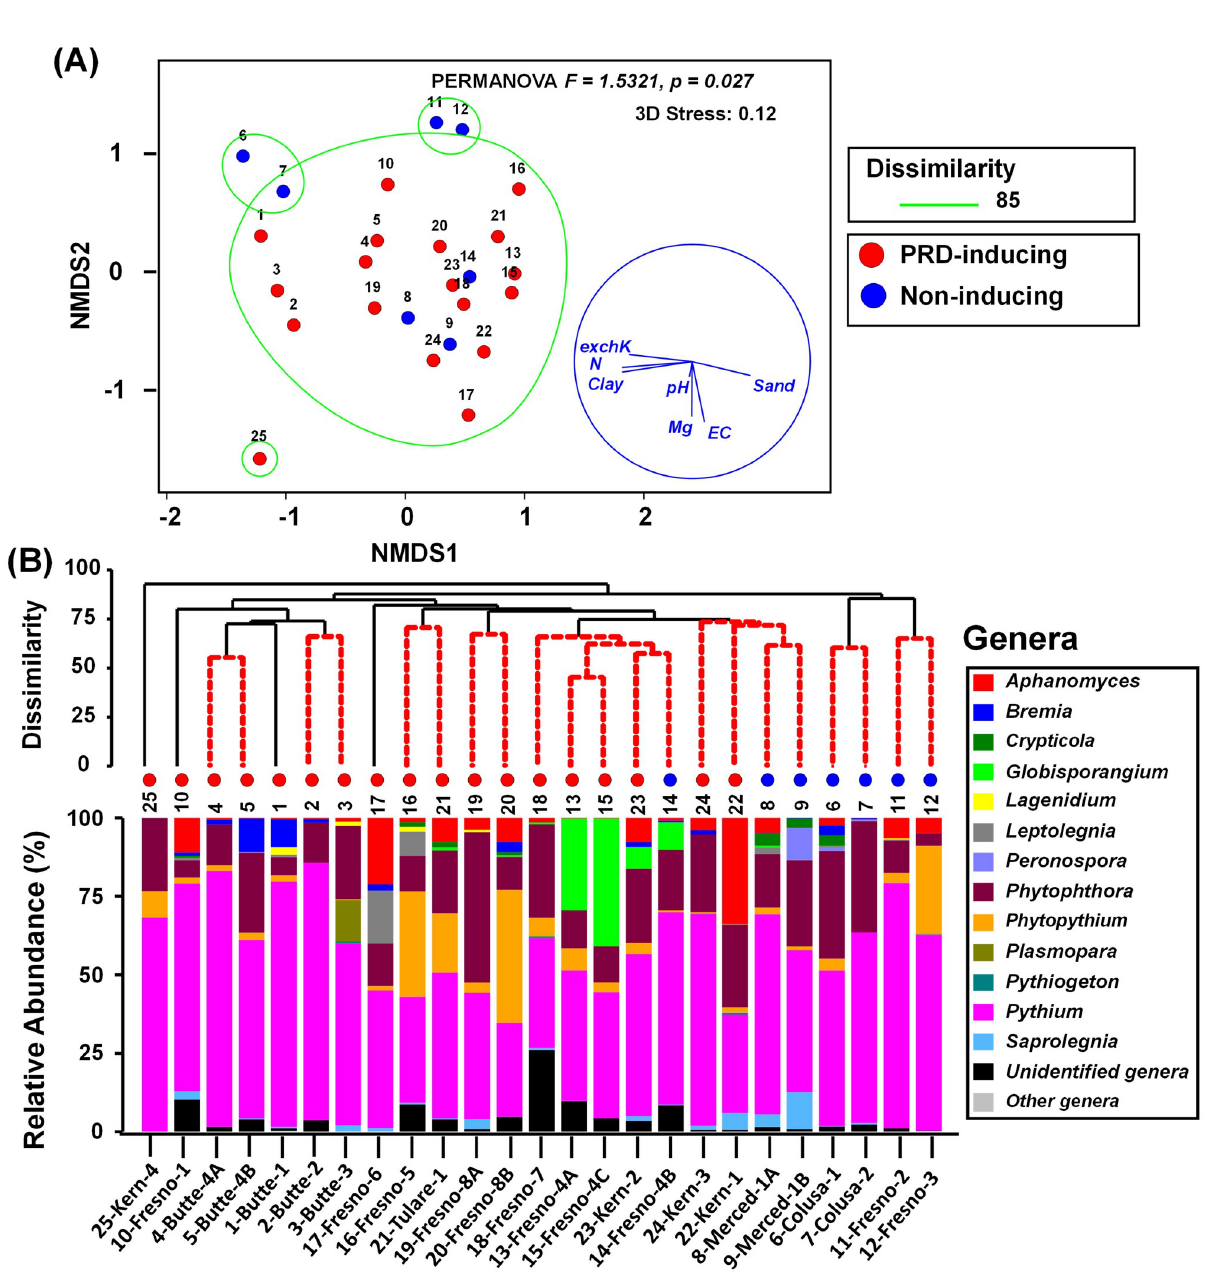
Fig 5. Characterization of soil oomycete community relationships and composition among PRD-inducing and non-inducing soils. (A) Non- metric multidimensional scaling (NMDS) ordination of soils based on Bray Curtis dissimilarity matrix (with overlays of hierarchical clustering at